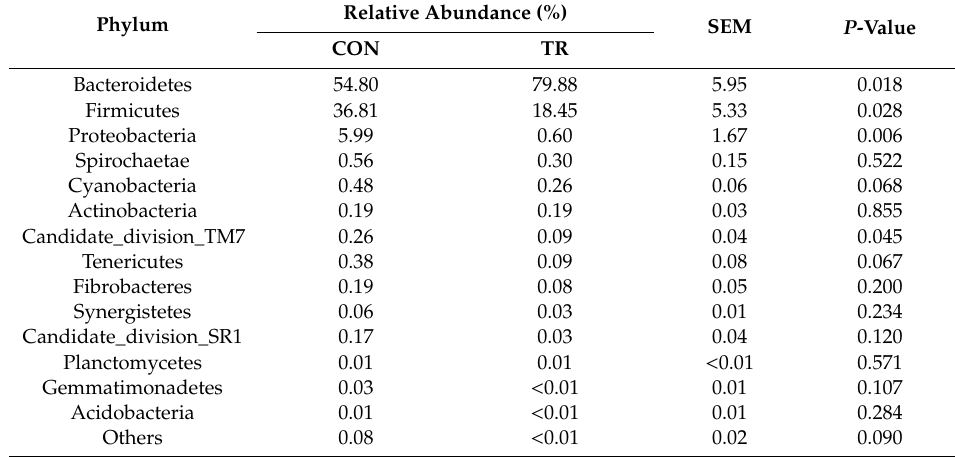
Table 5. The relative abundance of phylum level (% of total sequences) in ruminal bacterial communities of CON 1 and TR 2